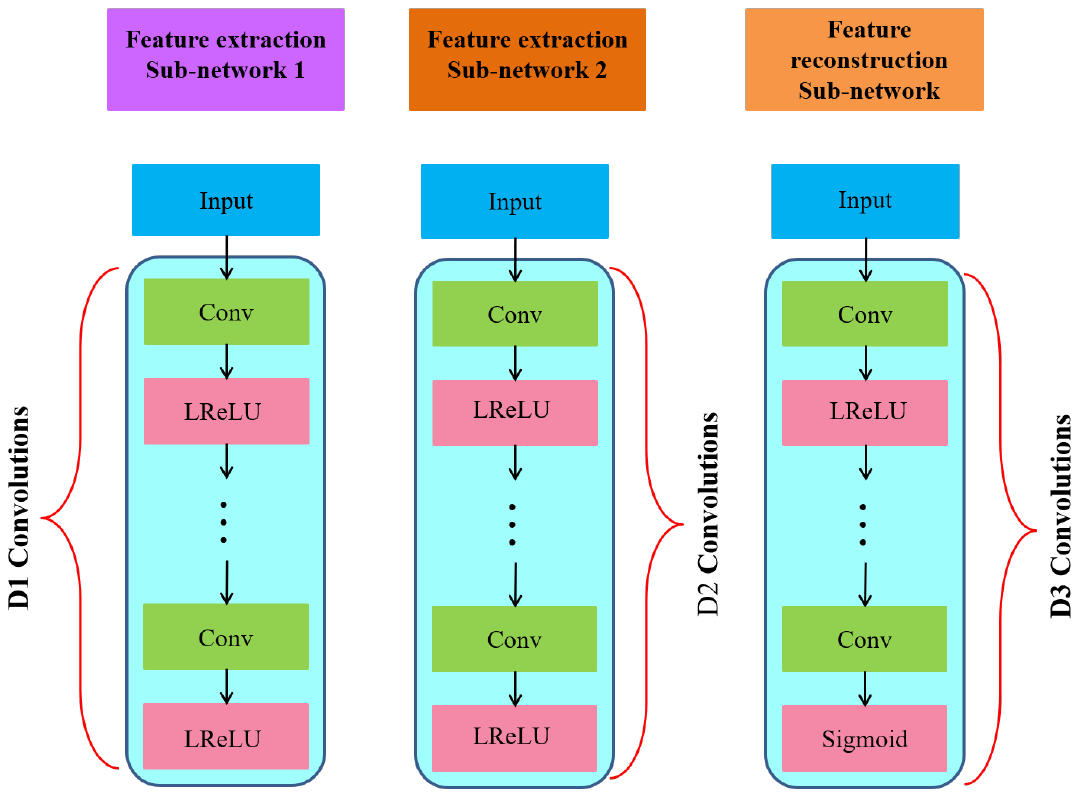
Figure 2. Structures of our feature extraction and reconstruction sub-networks. There are D1, D2, D3 convolutional layers in the three networks, respectively. The weights of convolutional layers are distinct among these three